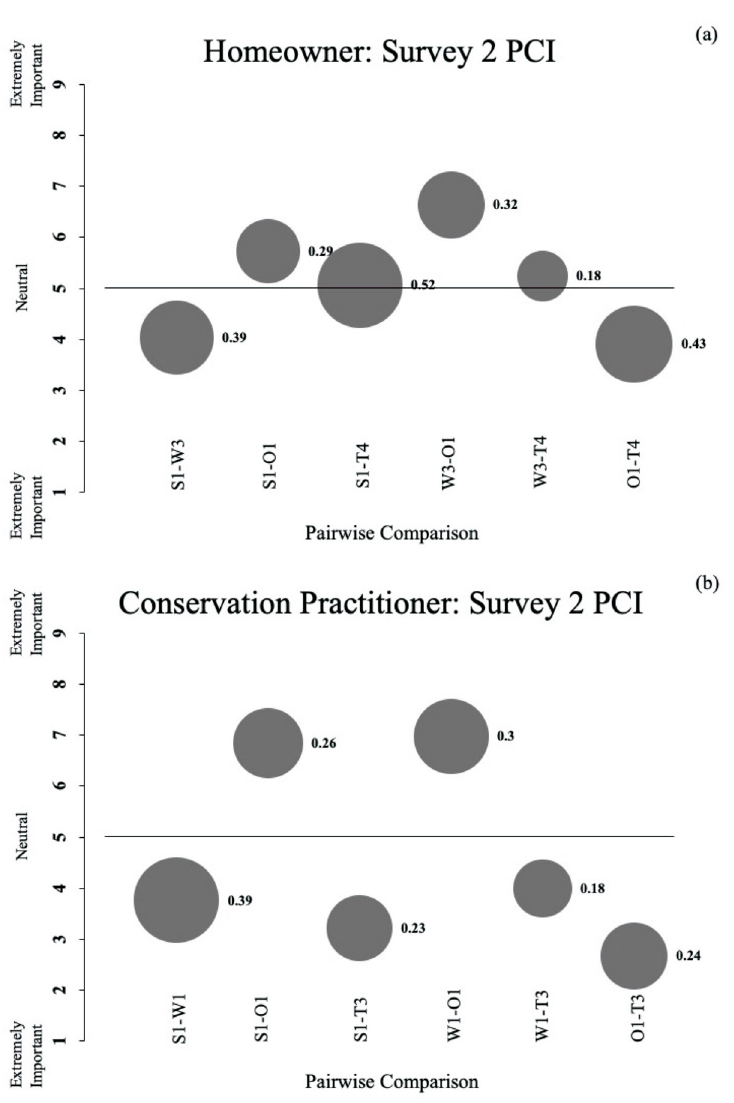
Fig 3. Potential for conflict indices from survey 2 for each stakeholder group. Illustration of the potential for conflict index (PCI 2 ) based on homeowner (a) and conservation practitioner (b) responses to Survey 2 in a study evaluating perceptions about potential outcomes of bird-window collision mitigation and prevention. Bubble size and values correspond and indicate the dispersion (conflict) among respondent answers (larger bubbles/numbers indicate greater conflict). The location of the bubble indicates the scale mean or the direction respondents lean in their answers to pairwise comparisons (e.g., 5 indicates completely neutral; values lower and higher than 5 indicate more non- neutral perceptions). Each bubble is an individual pairwise comparison indicated by the labels. Pairwise comparisons correspond visually to the y-axis scale (e.g., for S1-W3, 1 corresponds to S1 and 9 corresponds to W3). For a description of all strengths (S), weaknesses (W), opportunities (O), and threats (T), see Table 1.